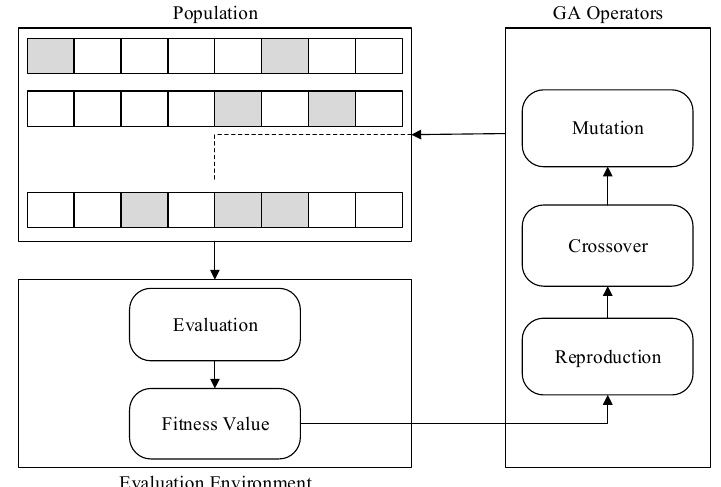
Figure 3. Based on the values of the population, the GA can be binary or real-coded. In this study, we used the real-coded GA.